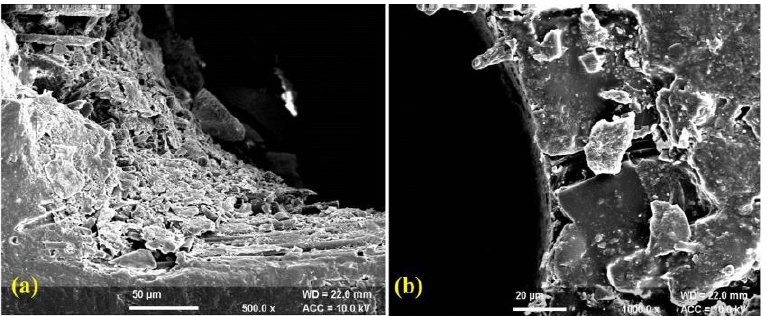
Figure 6. SEM of drilled micro-hole wall surface ( a ) Taguchi’s methodology ( b ) TOPSIS Method.